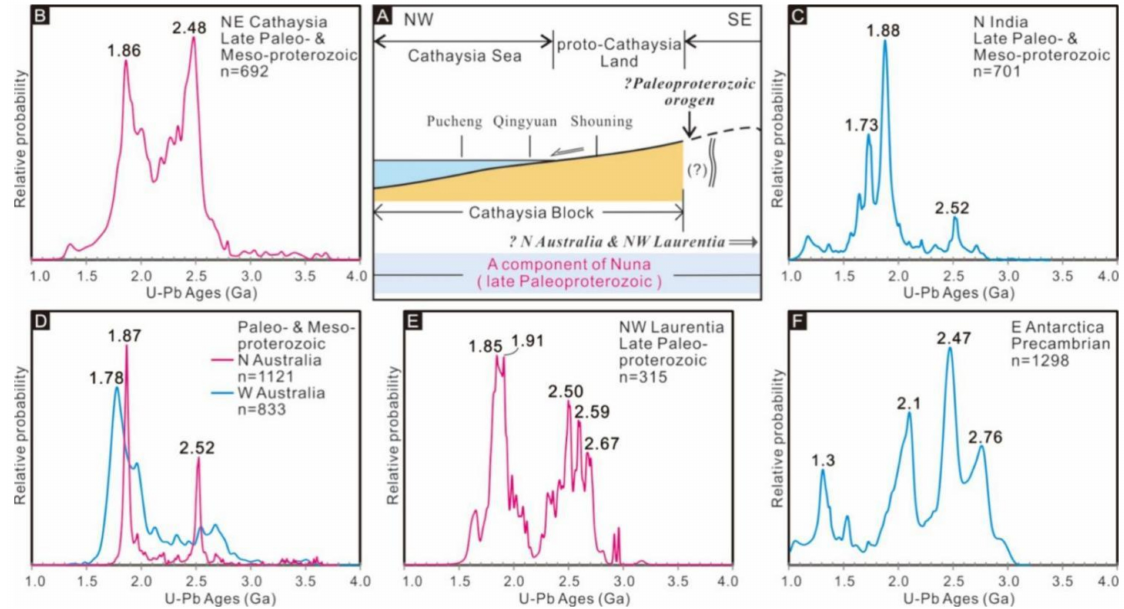
Figure 7. ( A ) Late Paleoproterozoic to early Mesoproterozoic landscape configuration of the